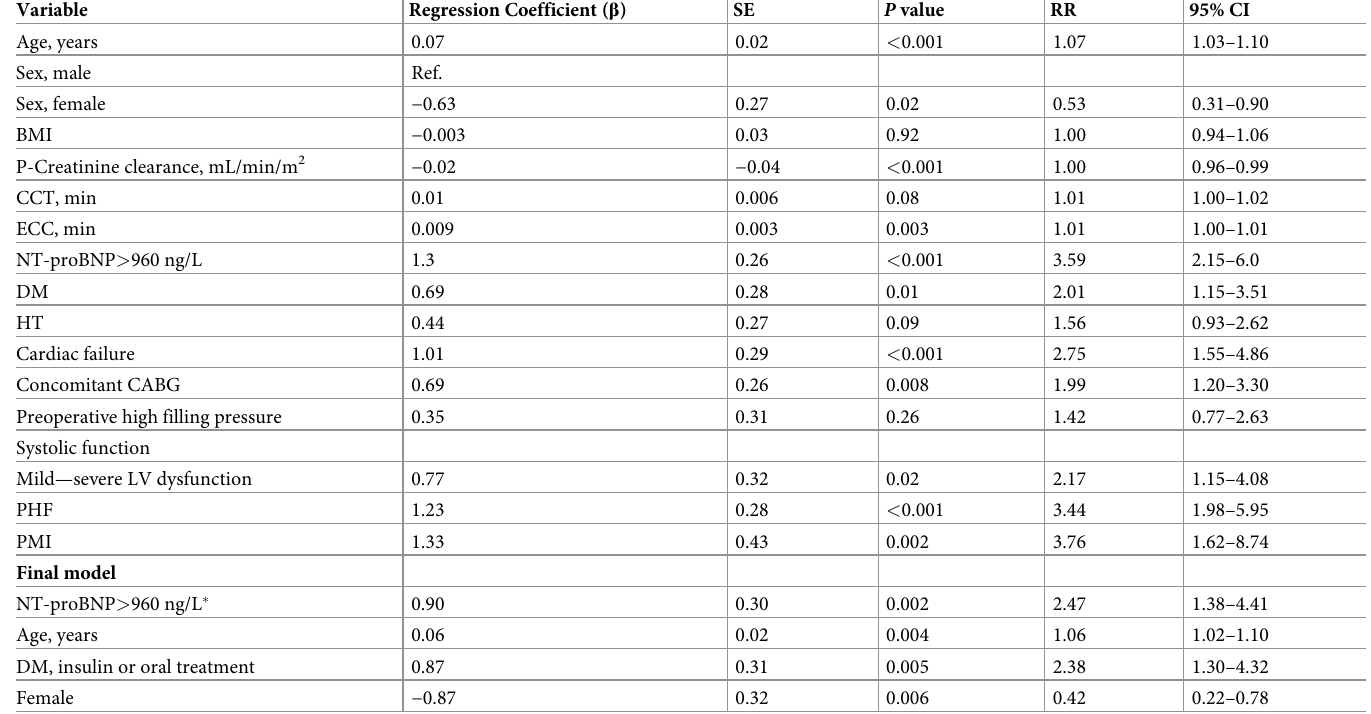
Table 6. Cox regression mortality, univariable and multivariable